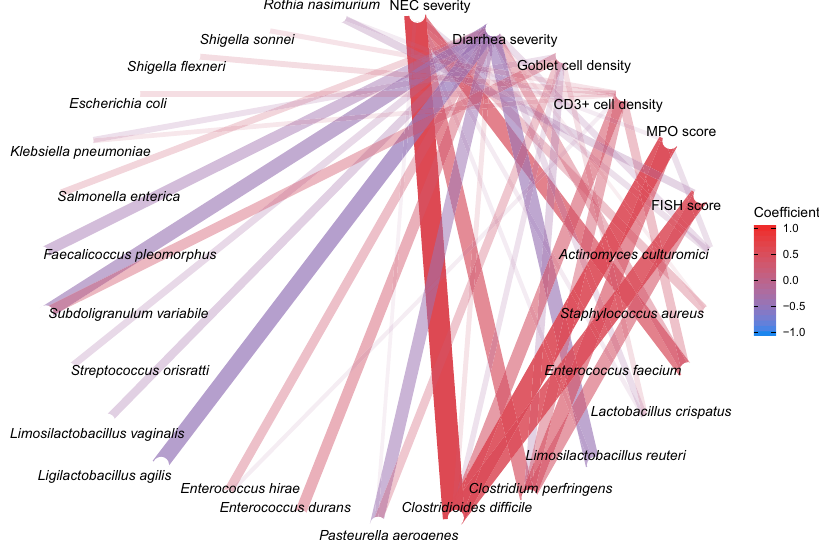
Fig. 6 Shifted gut microbiota composition was linked to gastrointestinal improvements. The core microbiome is used for correlation analysis (relative abundance > 1% among at least 10% of samples). The average NEC and diarrhea severity are taken as the indicators for gastrointestinal health, together with histological evaluation including goblet cell density, CD3 + cell density, and MPO score in colon and FISH score in the small intestine. The correlations are shown with absolute values of coef fi cients higher than 0.2. NEC necrotizing enterocolitis, MPO Streptococcus and lactobacilli phages being most prevalent (Fig. 7d). Escherichia , Klebsiella , and Salmonella ) and lactobacilli phages Most host-phages identi fi ed in the pairs were shared by the two (Supplementary Fig. 8), corresponding to the adequate host donors, except for unique phages predicted to attack Escherichia , abundance there. Using the spacer sequences, 92 host-phage Faecalicoccus and Clostridiales , which were only harbored by Donor 2. matches were found between the MAGs and vOTUs, with Escherichia ,